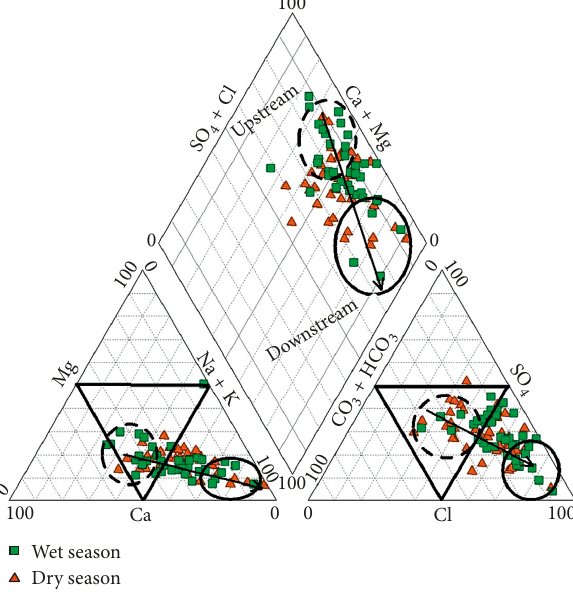
Figure 11: Piper diagram.